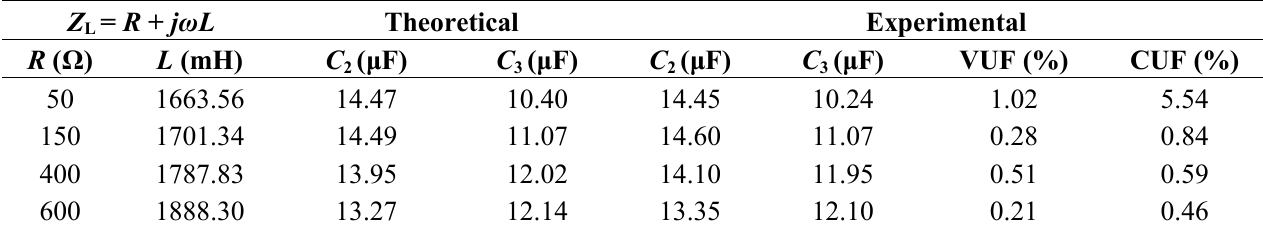
Table 5. Theoretical and experimental capacitance values and measured VUF and CUF for inductive